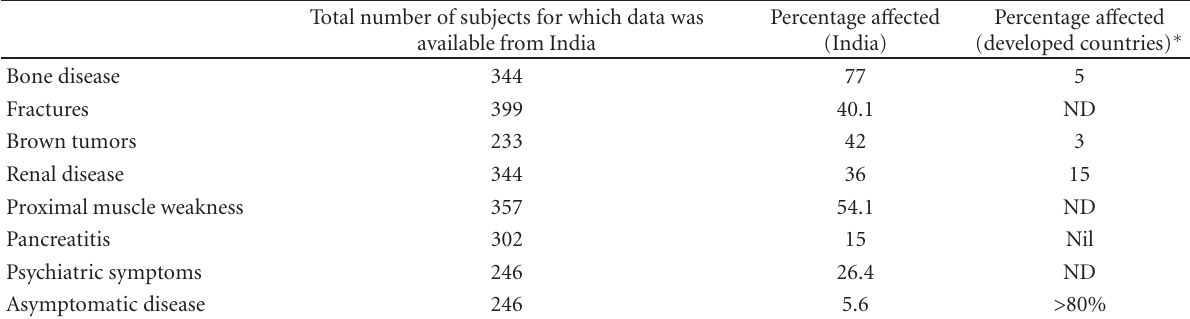
Table 1: Clinical characteristics of Indian PHPT and the developed world. Total number of subjects for which data was available from